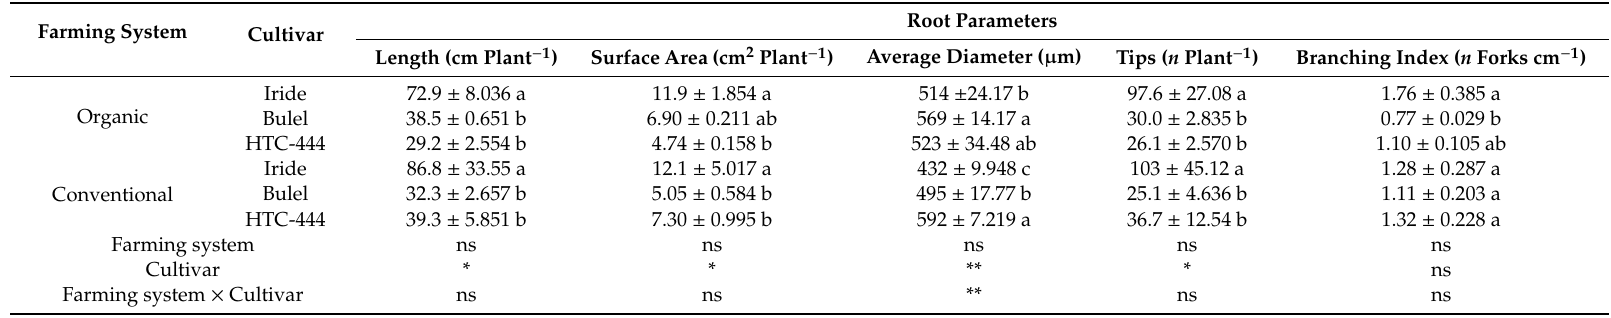
Table 1. Root length, surface area, diameter, tip density, and branching index (no. of forks / total root length) (mean ± SE; n = 3) in durum wheat (cv. Iride) and Tritordeum (cv. HTC-444 and Bulel) cultivated under organic and conventional agricultural systems. Letters indicate statistically significant di ff erences among cultivars within the same farming system (Newman–Keuls test, p ≤